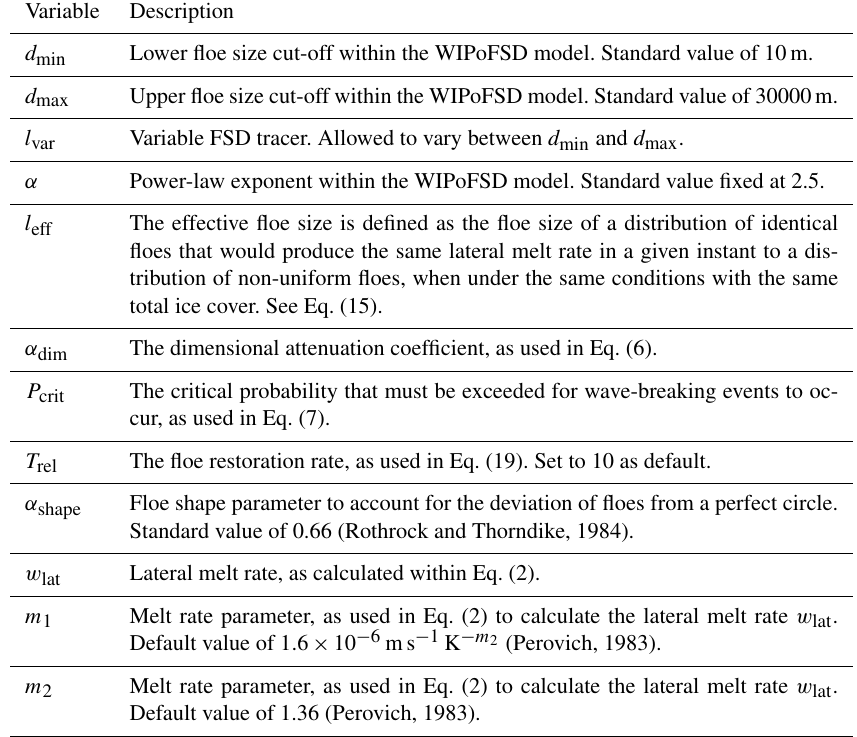
Table 1. Definitions of the parameters relating to the sensitivity studies described in Table 2. Variable